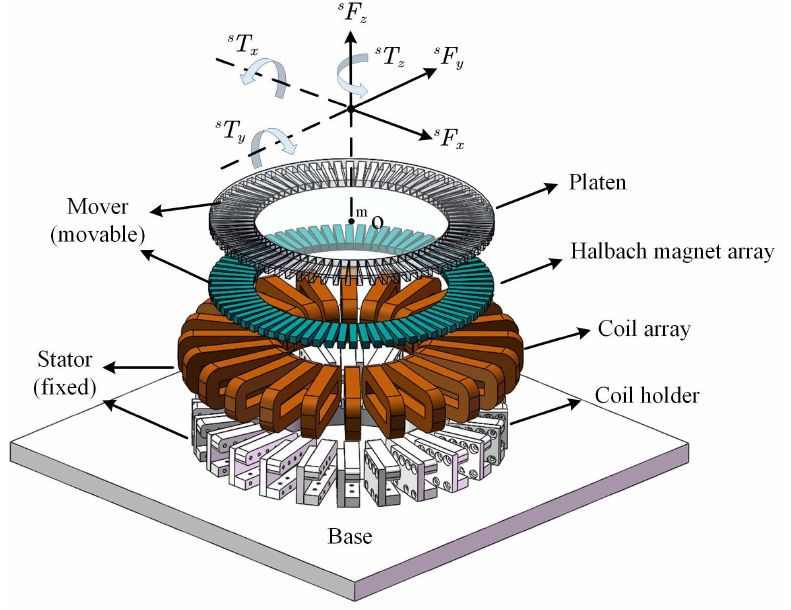
Figure 1. Exploded view of the proposed